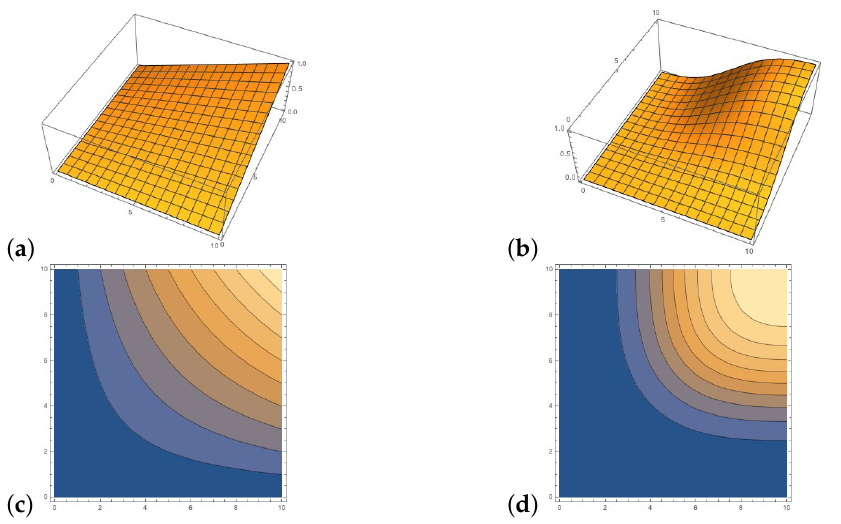
Figure 5. Multiplying two independent sampled events x and y with Ω = 10 leads to different